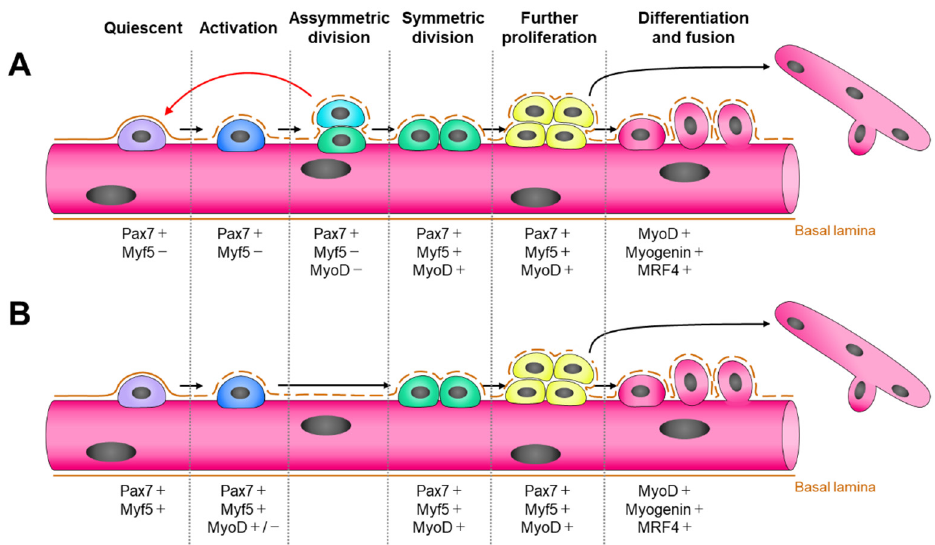
Figure 2. Expression of myogenic regulatory factors during different developmental stages of satellite cells. Cells can divide into two groups, myogenic stem cells (Pax7 + /Myf5 − ) ( A ) and myogenic precursor cells (Pax7 + /Myf5 + ) ( B ). The figures are referred from the review paper by Asfour et al. [40].